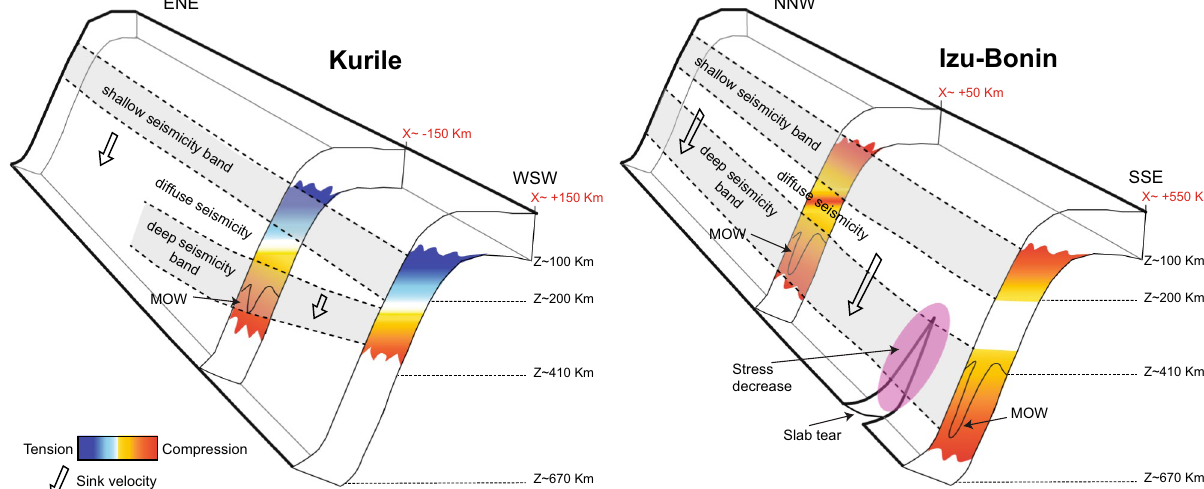
Figure 5. Sketch summarizing the features observed in the two subduction zones. The shallow and deep seismicity bands are drawn as gray stripes and are separated by the area of diffuse seismicity. The stress distribution with depth is schematically drawn along two cross sections for each subduction zone, with blue shading for tensional and red shading for compressional stress, darker colors meaning larger absolute values. The distance of the cross section in km along the profiles, according to Figs. 2, 3, S3, S4, is marked in red. The black wedge-shaped line at about 410 km depth represents the Metastable Olivine Wedge (MOW). The pink oval shape in Izu–Bonin roughly indicates the area of stress decrease due to the presence of a slab